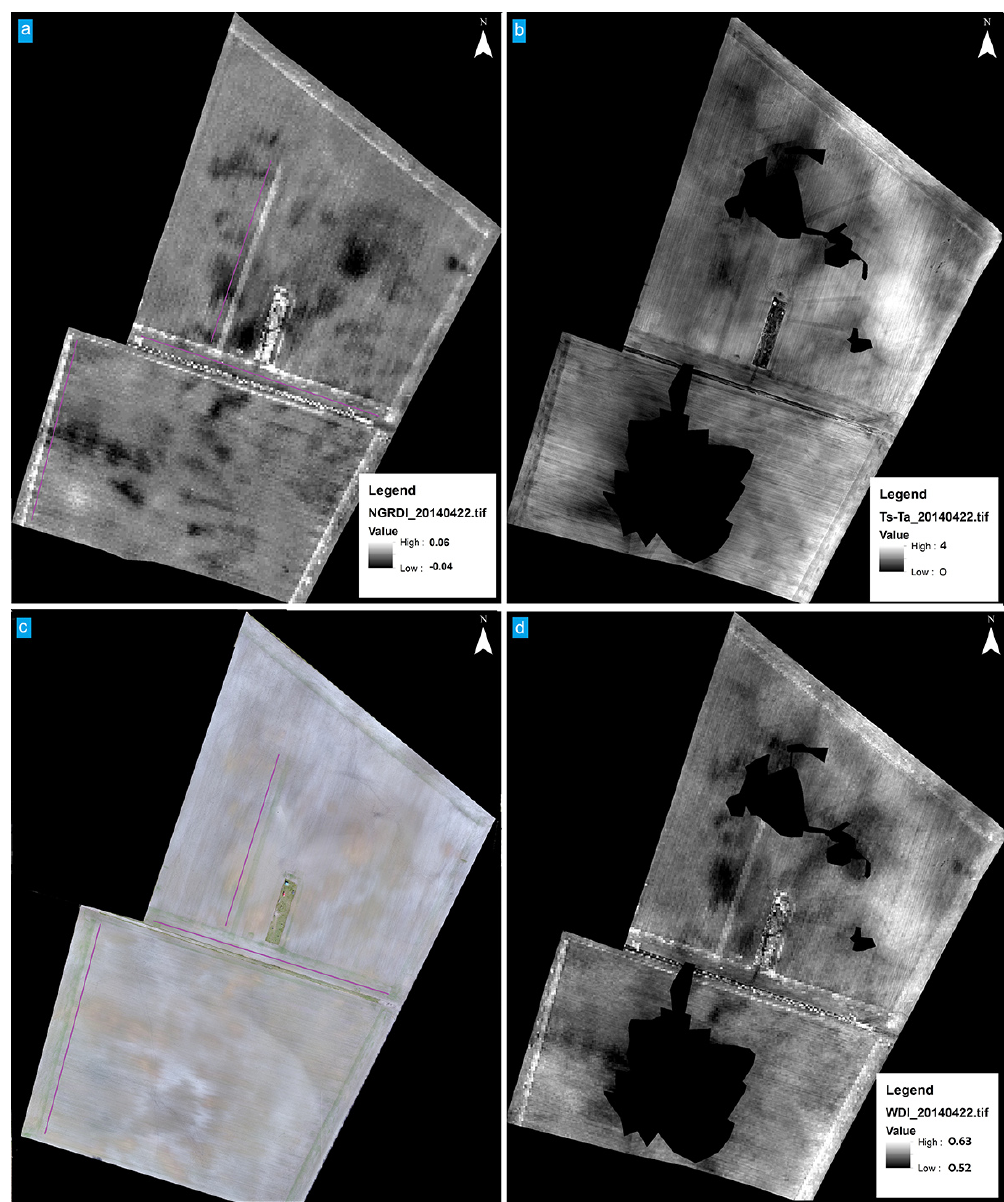
Figure 4. Imagery and indices from 22 April: (a) NGRDI, (b) T S − T A , (c) orthophoto (RGB data) and (d) WDI. Black areas (no data) within the field on thermal maps (b) and (d) are due to insufficient texture in images collected in these areas, which meant that the images could not be aligned with the structure-from-motion algorithm. The RGB imagery do not suffer from insufficient texture as these have a higher spatial resolution compared to the thermal imagery. Purple lines are placed next to green stripes of